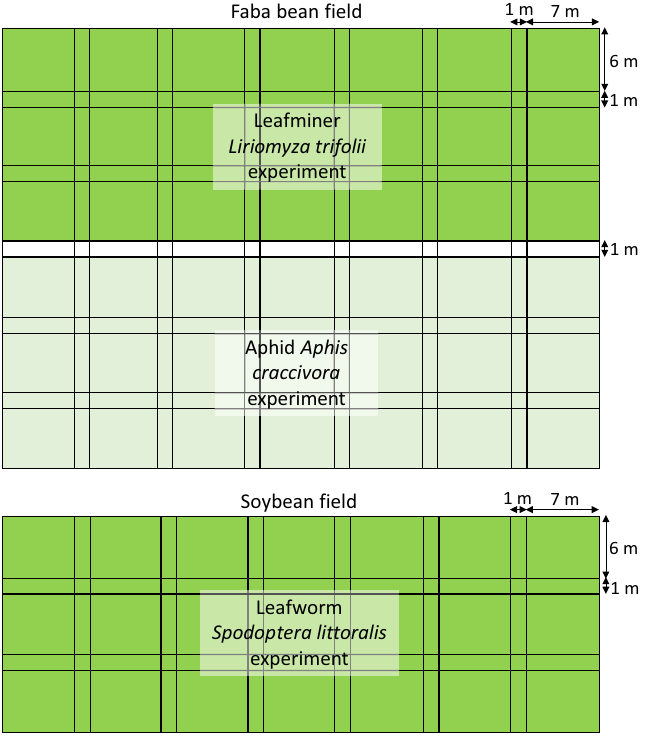
Figure 1. A schematic figure of the faba bean and soybean fields. Shared color of the field indicates the same